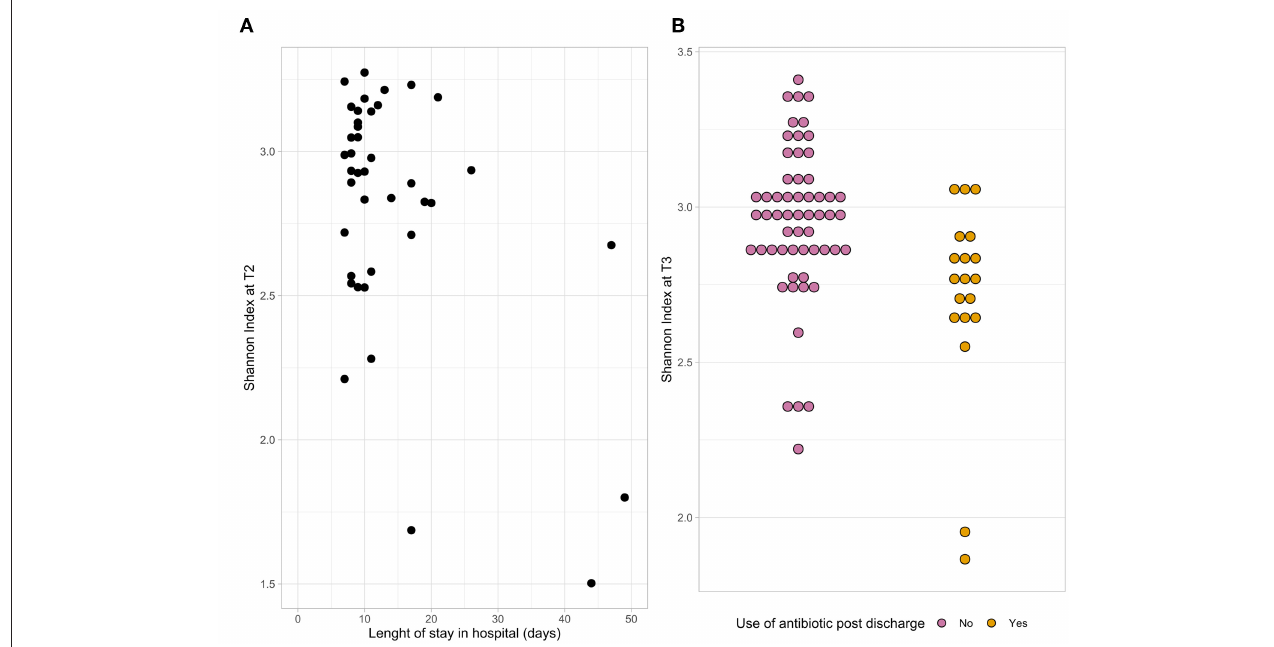
FIGURE 2 | The dot plots represent the association between the Shannon index at T2 and length of hospital stay (A) and the association between the Shannon index at T3 and antibiotic use after discharge (B)